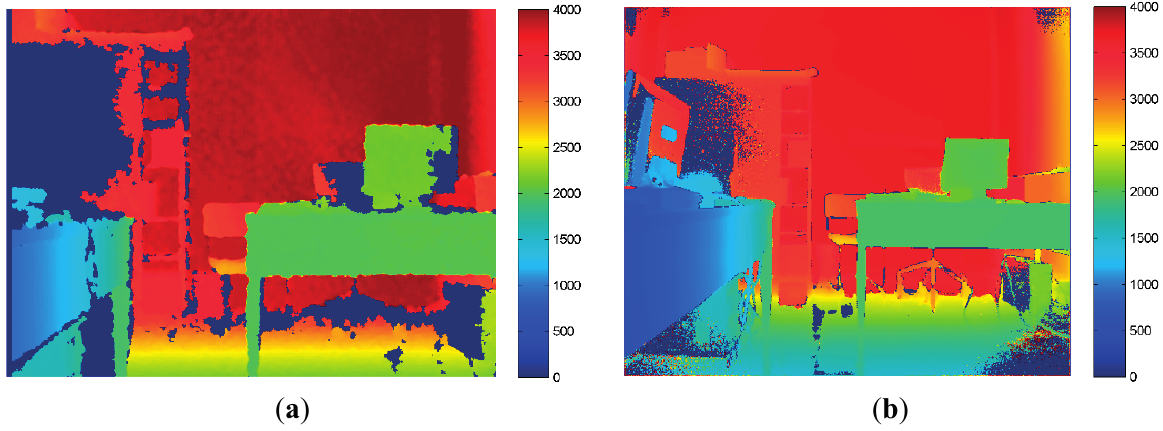
Figure 8. Depth maps delivered by Kinect 1.0 ( a ) and Kinect 2.0; ( b ) (mm). In dark blue are represented the no-data value delivered by the